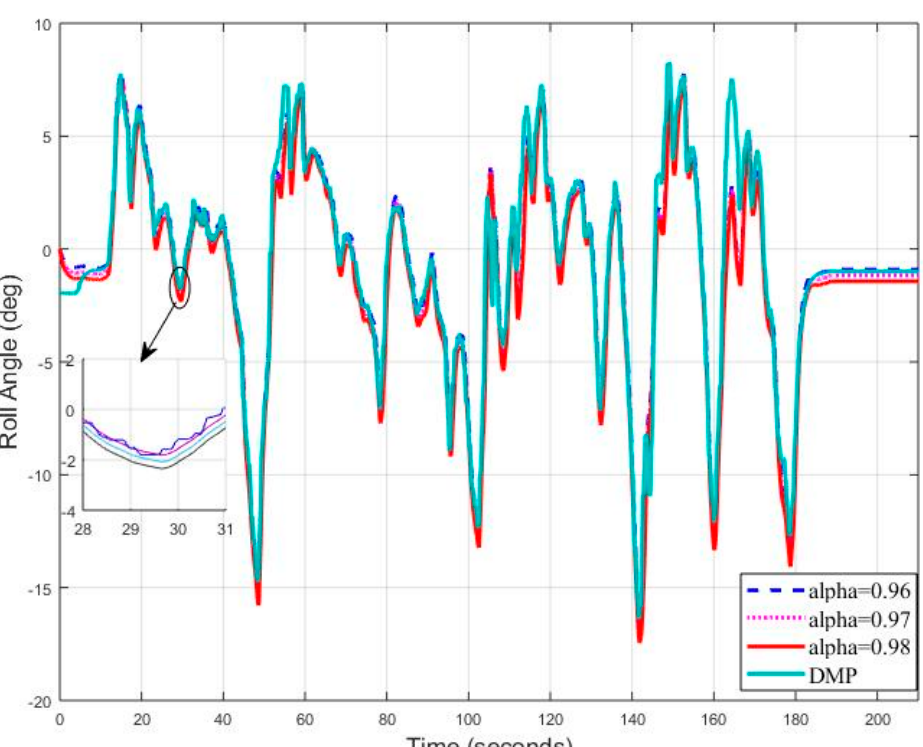
Figure 19. Real Time Roll Angle Estimate at f = 5 Hz for Complementary Filter .